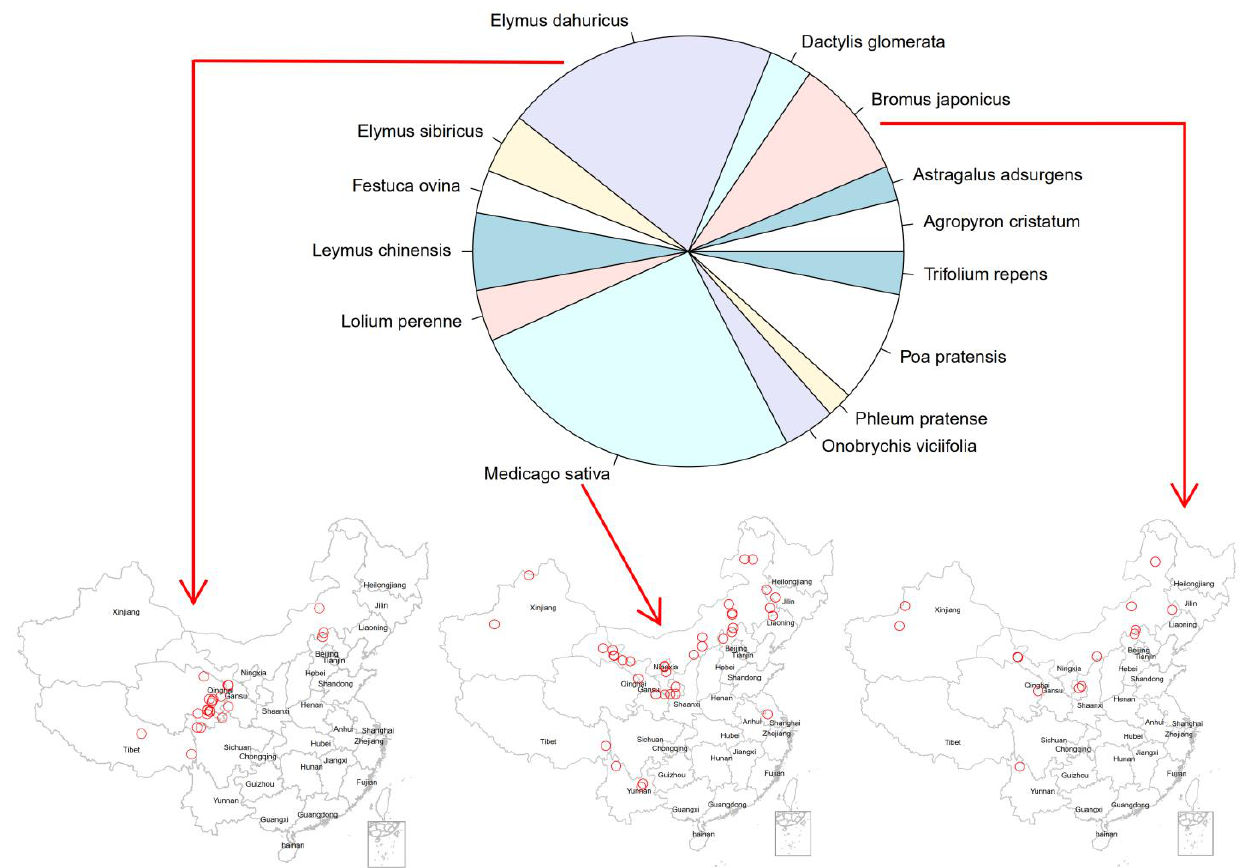
Figure A1. Proportions of plant species and spatial distribution of the top three species that were most commonly found in the 101 literature articles. Spatial distribution of the remaining 11 species is presented in Figure A2.